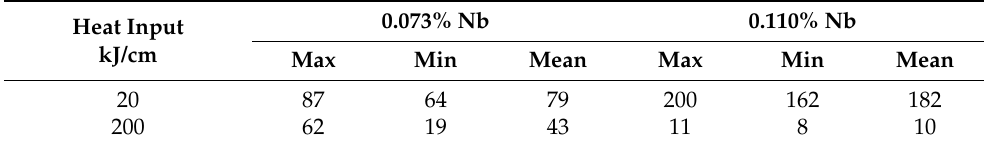
Table 7. Results of V-notch Charpy impact tests carried out on simulated CGHAZ at − 20 ◦ C